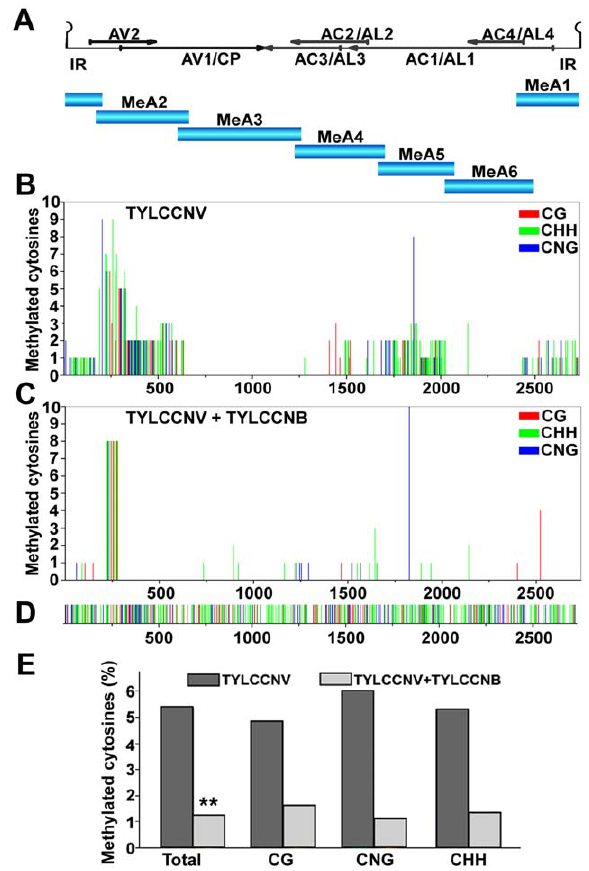
Figure 1. TYLCCNB reduces TYLCCNV DNA methylation genome-wide. N. benthamiana plants were inoculated with TYLCCNV alone or in combination with TYLCCNB. Samples were prepared by pooling six leaves from six systemically infected plants 21 days post- inoculation. DNA extracts were obtained, and the circular viral genome was divided into six fragments and PCR amplified after bisulfite treatment. Twenty clones from each fragment were sequenced. (A) The TYLCCNV genome is depicted in linear form, beginning within the conserved hairpin located in the intergenic region (IR). The positions of viral genes are shown by arrows. The six fragments used for bisulfite sequencing are indicated (MeA1 to MeA6). (B) The graph shows the total number of methylated cytosines at each position in the TYLCCNV genome, from a total of 20 sequenced clones, in different sequence contexts (CG red, CHH green, CNG blue). (C) As in (B), except DNA was obtained from plants co-inoculated with TYLCCNV + TYLCCNB. (D) The sequence contexts of all cytosines in the , 2,737 bp TYLCCNV strain Y10 genome are indicated. (E) The histogram shows the percentage of cytosine residues methylated in different sequence contexts in the TYLCCNV genome in plants inoculated with TYLCCNV alone or together with TYLCCNB. Student’s t test was performed on methylation values using individual clones as data points. The double asterisks indicate a significant difference between samples with and without TYLCCNB at the 99% confidence interval.